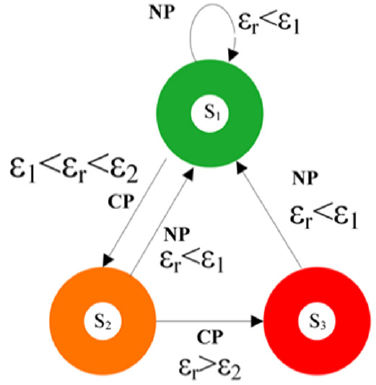
Figure 2. Finite-SM realization of subject.